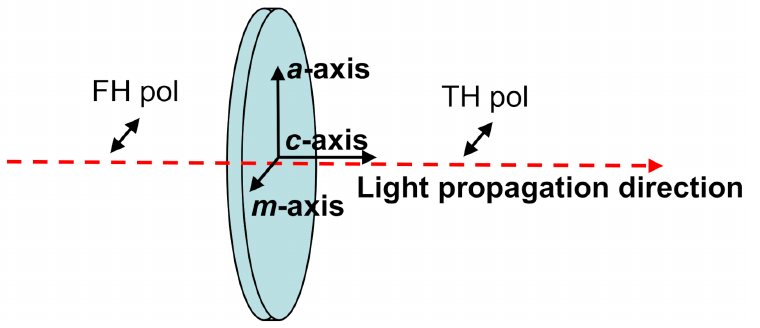
Figure 5. Schematic representation of crystallographic a , c , and m axes relative to the investigated GaN sample plane. The light propagation direction and its polarization are also